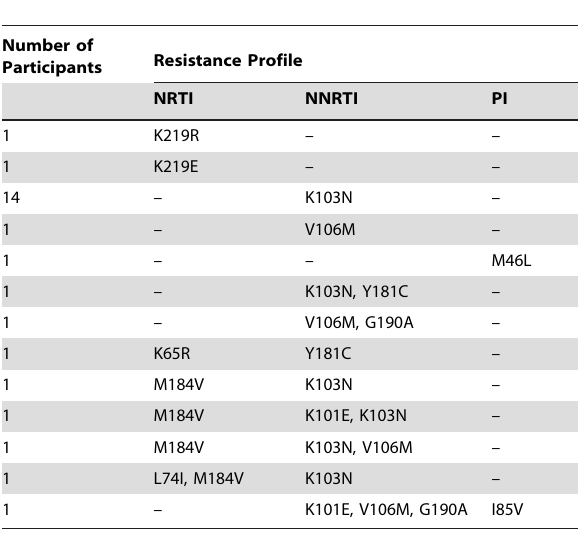
Table 2. Major Drug Resistance Mutation Profiles